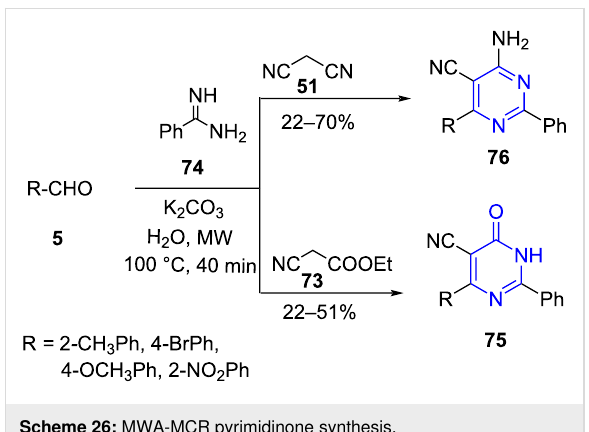
tion conditions, longer reaction time and low yields